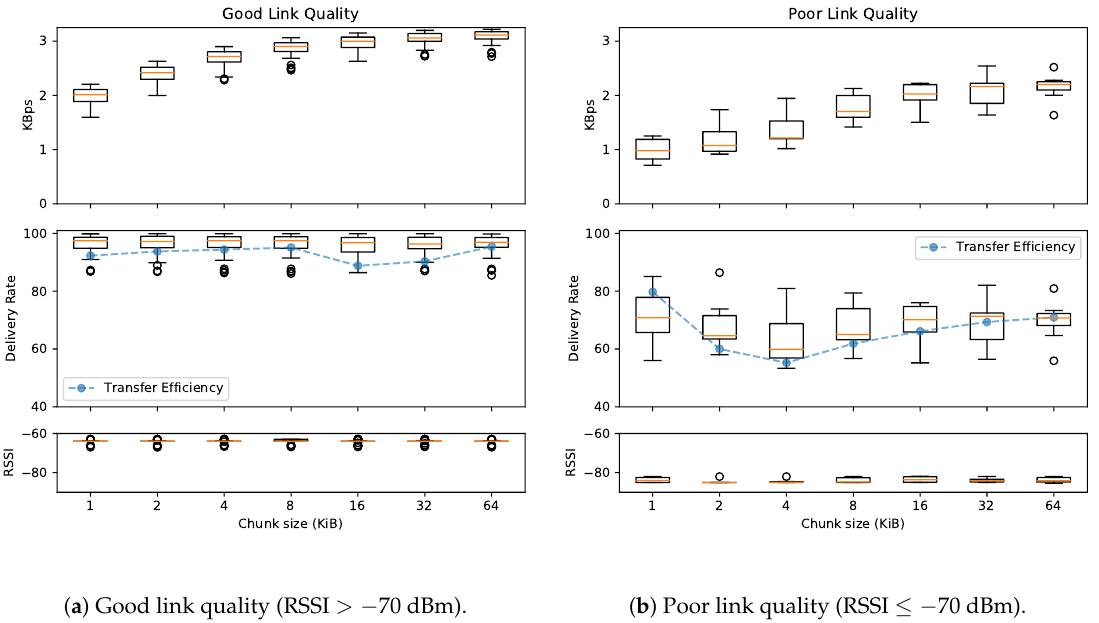
Figure 9. Achieved data throughput transferring 1 MiB of random data between two XBee 802.15.4 series 1 radios with XTP and various chunk sizes over both good and poor quality